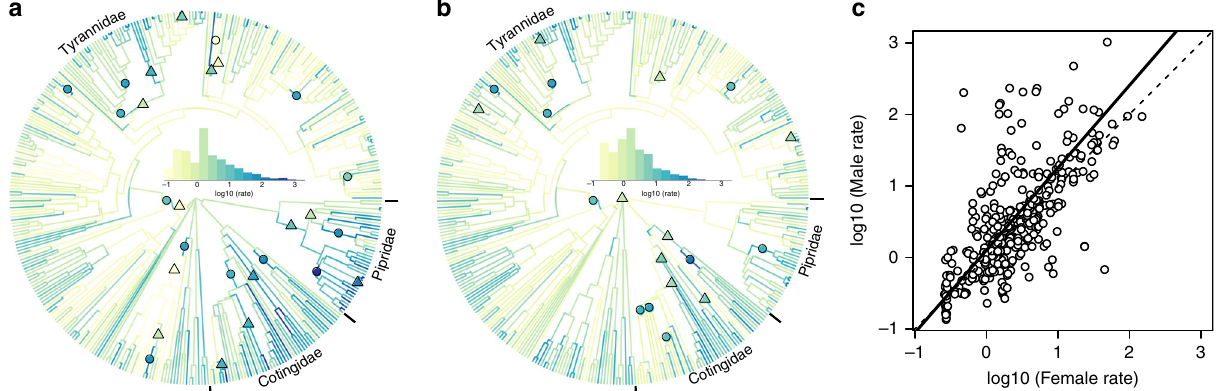
Fig. 1 Sex-speci fi c rate variation in plumage colour evolution across the Tyrannida phylogeny. a , b Plots showing the Tyrannida phylogeny ( n = 372 spp.) coloured by estimates of mean relative multivariate rate of plumage colour evolution based on ten body patches for males ( a ) and females ( b ). Coloured shapes show the location of signi fi cant (posterior probability > 0.99) rate shifts affecting whole clades (triangles) and individual internal branches (circles) (shape colour re fl ects rate estimate; see Methods for details). Histograms (inset) show the rate distribution for each tree. c Relationship between (log 10 transformed) male and female rates of plumage colour evolution (TR ES values) across species. Phylogenetic reduced major axis regression (solid) and one- to-one (dashed) lines shown. Equation of the regression line: y = 0.10 + 1.15*x ( R 2 = 0.45), which is signi fi cantly different to a one-to-one slope ( T = 3.69, d.f. = 304.08, P = < Comparing species-speci fi c trait rates (TR ES ) of male and female plumage colour evolution estimated using a method summarising rate variation across the phylogeny (see Methods) revealed that rates of plumage colour evolution are correlated between the sexes, but that males typically diverge faster than females (Fig. 1c and Supplementary Fig. 2). The phylogenetic major axis regression line relating male and female rates was signi fi cantly greater than one, indicating that as average within- species rate increases, rates of plumage colour evolution become signi fi cantly more male biased (Fig. 1c).